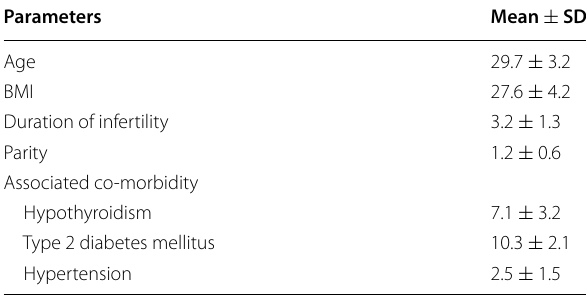
Table 1 Demographic characteristics of the patients